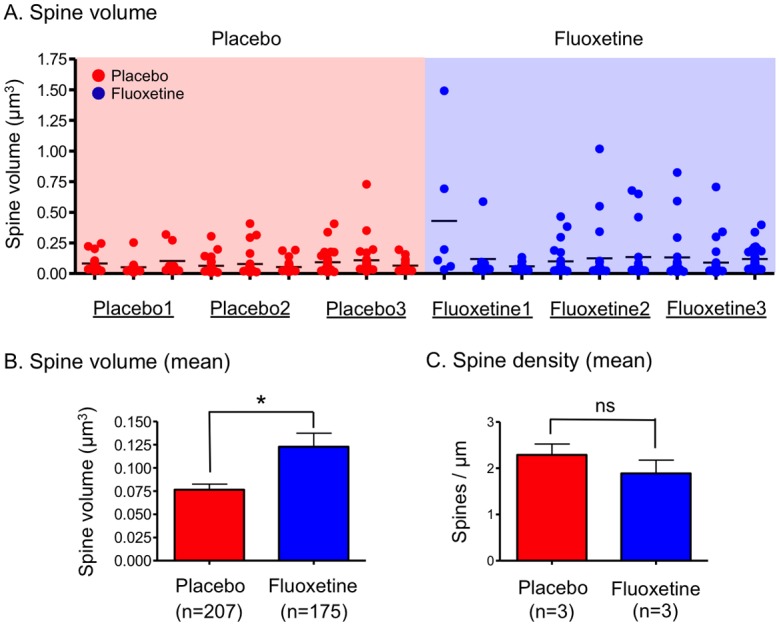
Spine volume and density in the placebo- and fluoxetine-treated mice.(A) The scatter plot shows the spine volume in mice treated with placebo (n = 207 spines from 9 dendrites, 3 dendrites per each of 3 mice) or fluoxetine (n = 175 spines from 9 dendrites, 3 dendrites per each of 3 mice). (B, C) Mean values of spine volume for all spines (Mann-Whitney U-test: U = 15930, p = 0.0425) (B) and spine density (Mann-Whitney U-test: U = 28, p = 0.2973) (C) in the placebo- or fluoxetine-treated mice. *p < 0.05 compared with the placebo-treated mice.